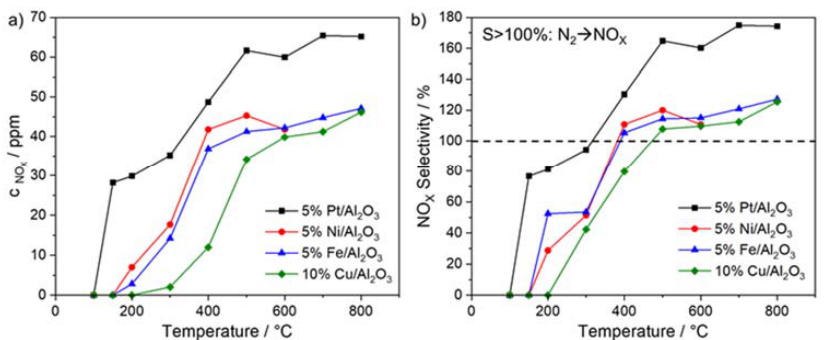
Figure 6. ( a ) NO X concentration and ( b ) NO X selectivity vs. reaction temperature for different transition metal catalysts, platinum-based catalyst shown for comparison, WHSV = 600 L/g h.